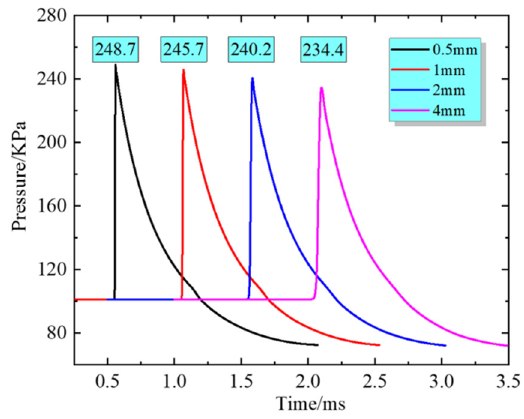
Figure 5. Grid convergence checking.